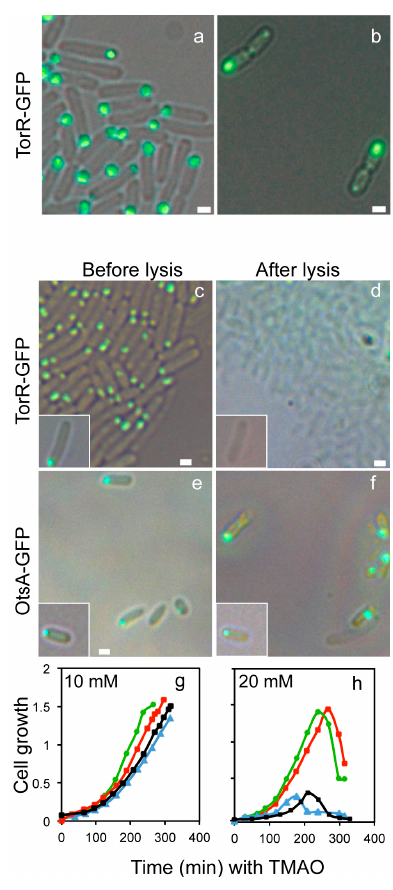
Figure 1. The TorR ‐ green fluorescent protein (GFP) fusion localizes at the old cell poles as a focus. Exponentially growing cells in ABTGcasa containing isopropyl β‐ D ‐ 1 ‐ thiogalactopyranoside (IPTG) to induce expression of TorR ‐ GFP from the pTorR ‐ GFP plasmid at 37 °C were fixed in 70% ethanol. The TorR ‐ GFP fusion was then visualized by fluorescence microscopy. ( a , b ) represent cells of W3110 Δ torR /pTorR ‐ GFP with green TorR ‐ GFP fusion. Cells expressing TorR ‐ GFP ( c , d ) or OtsA ‐ GFP ( e , f ) were exponentially grown and visualized in 1.2% agarose pads of ABTGcasa medium before ( c , e ) and after ( d , f ) cell lysis (2 mg/mL lysozyme, 0.1% Triton X ‐ 100, and 10 mM EDTA). The insets indicate the same cell before and after cell lysis. The scale bars represent 1 μ m. Exponentially growing wild ‐ type W3110 (green), W3110 Δ torR (blue) and W3110 Δ torR /pTorR ‐ GFP cells with IPTG (red) and without IPTG (black) were diluted 10 times in ABTGcasa with 10 mM ( g ) or 20 mM Trimethylamine N ‐ oxide (TMAO) ( h ), and growth curves were monitored. The X axis presents time in TMAO and Y axis indicates cell growth measured by cell density (OD 450 ). The values are the average of three experiments.